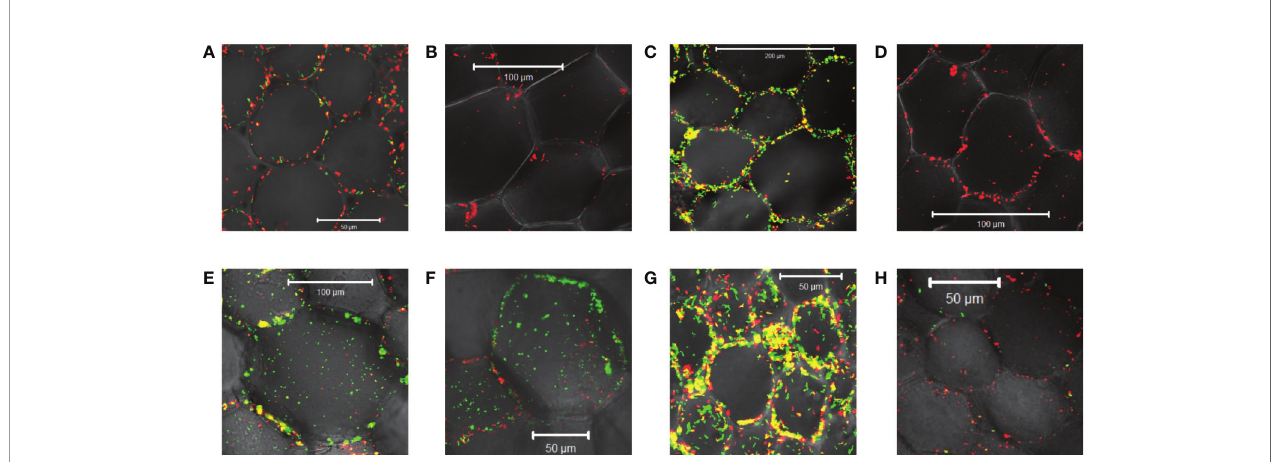
FIGURE 4 | Virulence induction events in tobacco vs. maize midrib explants. AB650 wt with explants of tobacco (A) and maize (B) on glycerol plates; YHL301 ss with explants of tobacco (C) and maize (D) on glycerol plates; YHL324 s+ with explants of tobacco (E) and maize (F) on glycerol plates; AB650 wt with tobacco explants on glucose plates (G) , and AB650 wt with tobacco explants on AS plates (H)